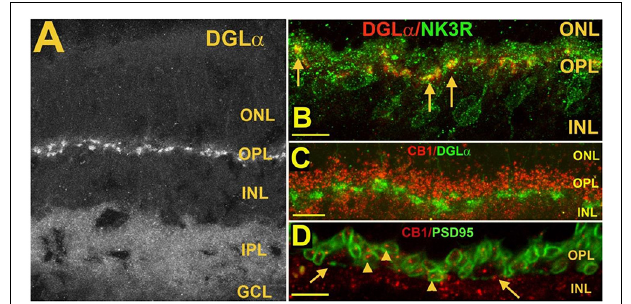
FIGURE 6 | Postsynaptic diacylglycerol lipase α (DGL α ) in Type 1 OFF cone bipolar cells, is juxtaposed to presynaptic CB1 in photoreceptor terminals. (A) DGL α staining in the mouse retina. (B) DGL α (red) colocalizes with post-synaptic terminals of Type 1 OFF bipolar cells, as marked by NK3R (green, arrows). (C) Flattened Z-series indicates CB 1 (red) closely juxtaposes distal to DGL α (green), consistent with rod spherule and cone pedicle localization. (D) CB 1 (red) costaining with PSD95, which outlines rod spherules (arrows) and cone pedicles (angled arrows) shows CB 1 present within terminals of both rod and cone photoreceptor terminals. Scale bars: (A) : 50 µ m; (B–D) : 25 µ m. Adapted from Hu et al. (2010).